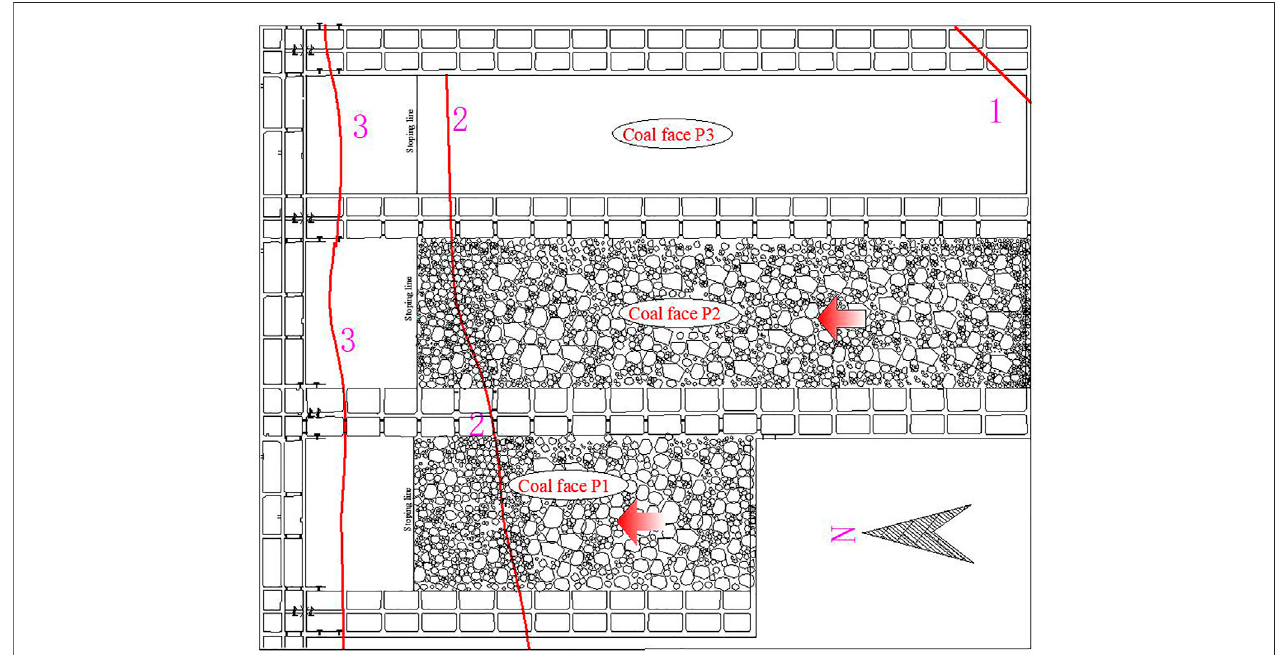
FIGURE 1 | Gullies of working faces P2 and P3.